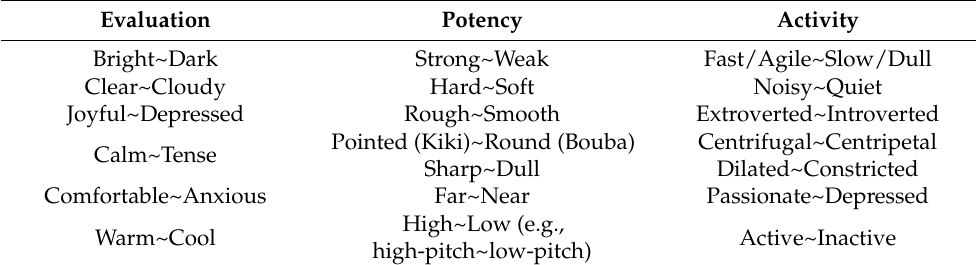
Table 5. Modified concept pairs of adjectives originally from Osgood [57]